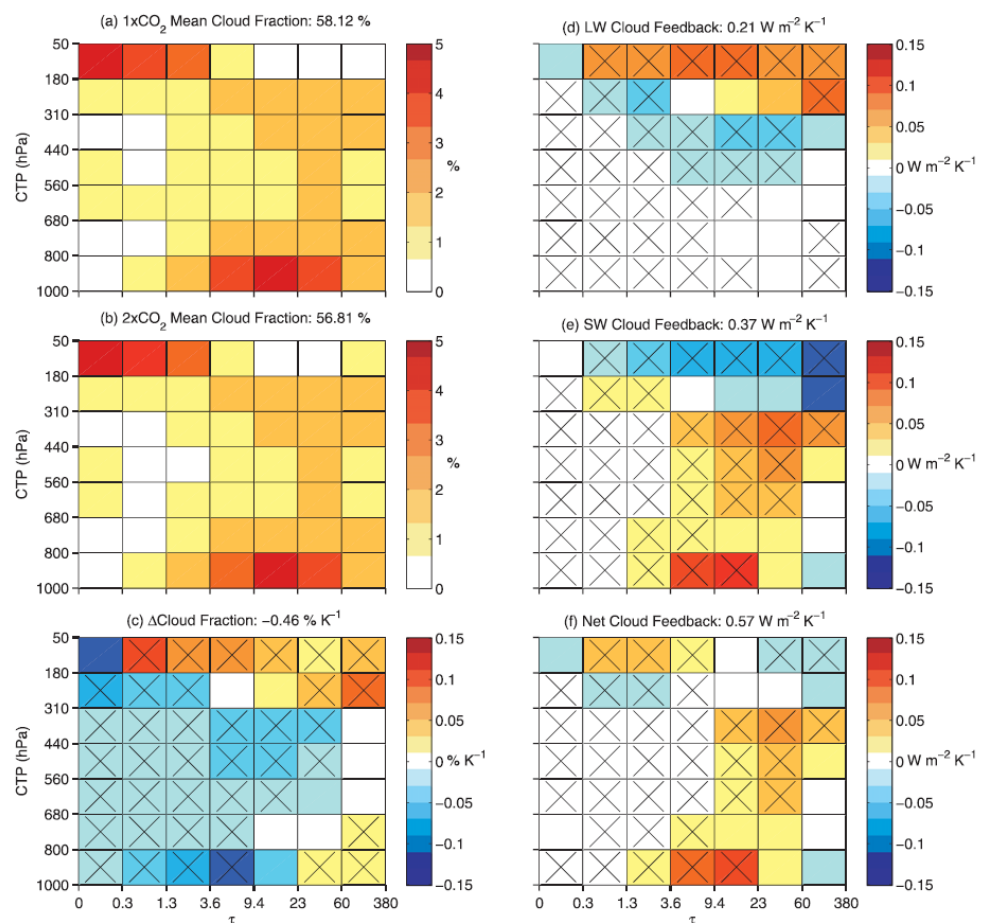
Figure 5. Global, annual, and ensemble mean cloud fractions for the (a) 1 × CO 2 and (b) 2 × CO 2 runs, along with (c) the average difference expressed per unit change in each model’s global mean surface air temperature between the two states. Matrix resulting from multiplying the change in cloud fraction at each location and month by the collocated (d) LW, (e) SW, and (f) net cloud radiative kernels, and then taking the global, annual, and ensemble means. The sum of each matrix is shown in each title. Bins containing an “ × ” indicate those in which ≥ 75% of the models agree on the sign of the field plotted. Reprinted from Zelinka et al. (2012), ©American Meteorological Society. Used with